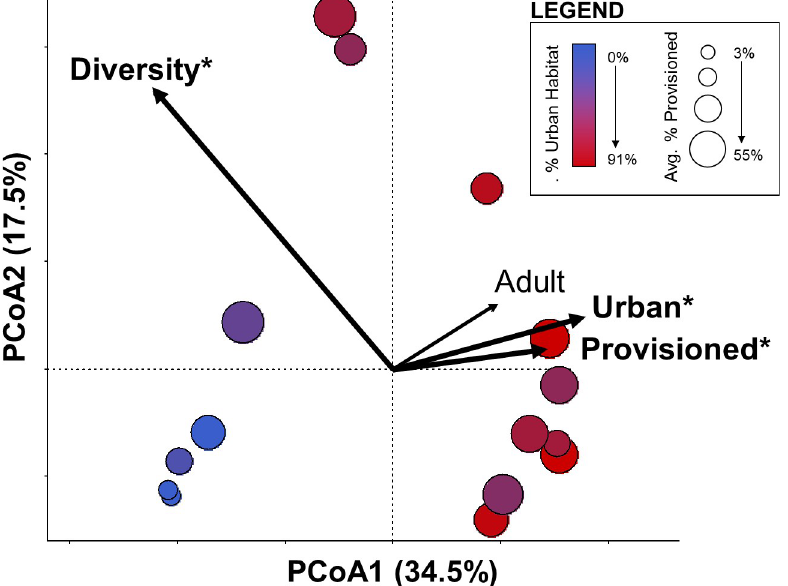
Fig 2. Relationship between bacterial community composition to urbanization, dietary provisioning, age, and genus diversity. Principal coordinates analysis demonstrated site-level patterning in bacterial community composition at the genus level that corresponded to urban land cover (red to blue gradient) and use of provisioned food by ibises (circle size) at capture sites, but not age composition of sampled birds (See text for statistics). Genus-level Shannon diversity associated with the community composition, increasing in the opposite direction of these independent